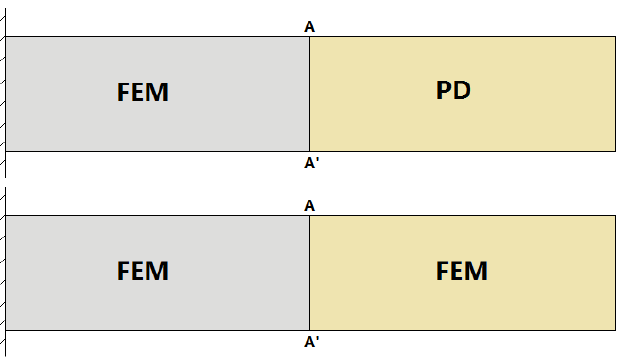
Figure 4. PD-FEM coupling model of the cantilever beamThe simulated deflection at the free end of the beam and the coupling force are presented in Table 1. The deflection and force obtained from the proposed coupling approach are very close to the FEM results (error less than 2%), which indicates that the coupling approach transfers the force accurately. Table 1. Simulation results of bending beam.